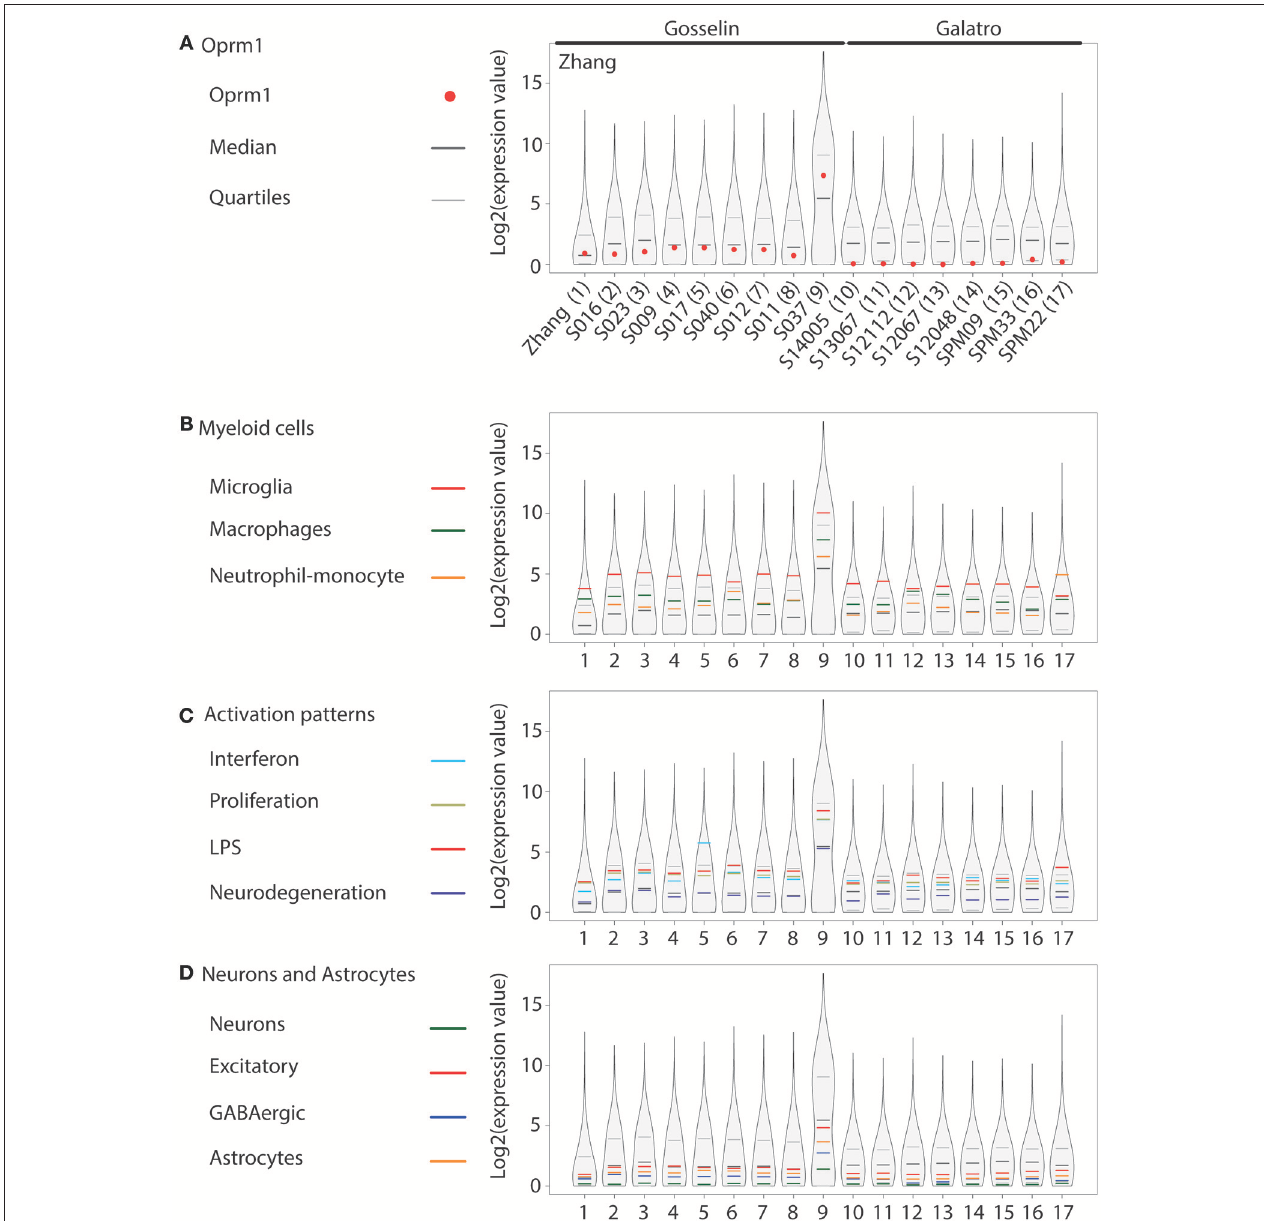
FIGURE 4 | Oprm1 and gene clusters expression in human cortex microglia datasets. Expression levels of the genes identified in each dataset are represented in violin plots demonstrating the median, as well as the 25th and 75th quartiles. In all datasets, microglia were assayed with RNA-seq. Gosselin datasets (#2–9) comprised of microglia isolated from young males and females, while the other human datasets were from adult and aged postmortem samples of unknown gender (#1) or exclusively males (10–17). Datasets are represented by name of the first author (A) , which are denoted numerically in (B–D) . (A) Oprm1 expression values were distributed below or along the median in the Zhang and Gosselin datasets (#1 and 2–9) but consistently below the median in all the Galatro datasets. (B) In the Myeloid gene clusters, the Microglia- related genes were the most highly expressed in all datasets analyzed, with expression values distributed above the 75th quantile, except in dataset #17 which had higher expression values for the Monocytes-Neutrophils-related genes. (C) Activation pattern gene clusters were highly expressed in purified human microglia, distributed within, and above the 75 th quantile. The majority of the datasets reported the highest expression values for the LPS-related genes. Interferon-related genes had the highest expression values in the datasets #5, 10, 14, and 16 with causes of death associated with blood circulation and aneurysm. (D) Neuron-, GABAergic-, and Astrocyte-related genes had expression values along and below the median in dataset#1 and those provided by Gosselin (#2–9). Expression values were all below the median in the aged samples (#10–17).